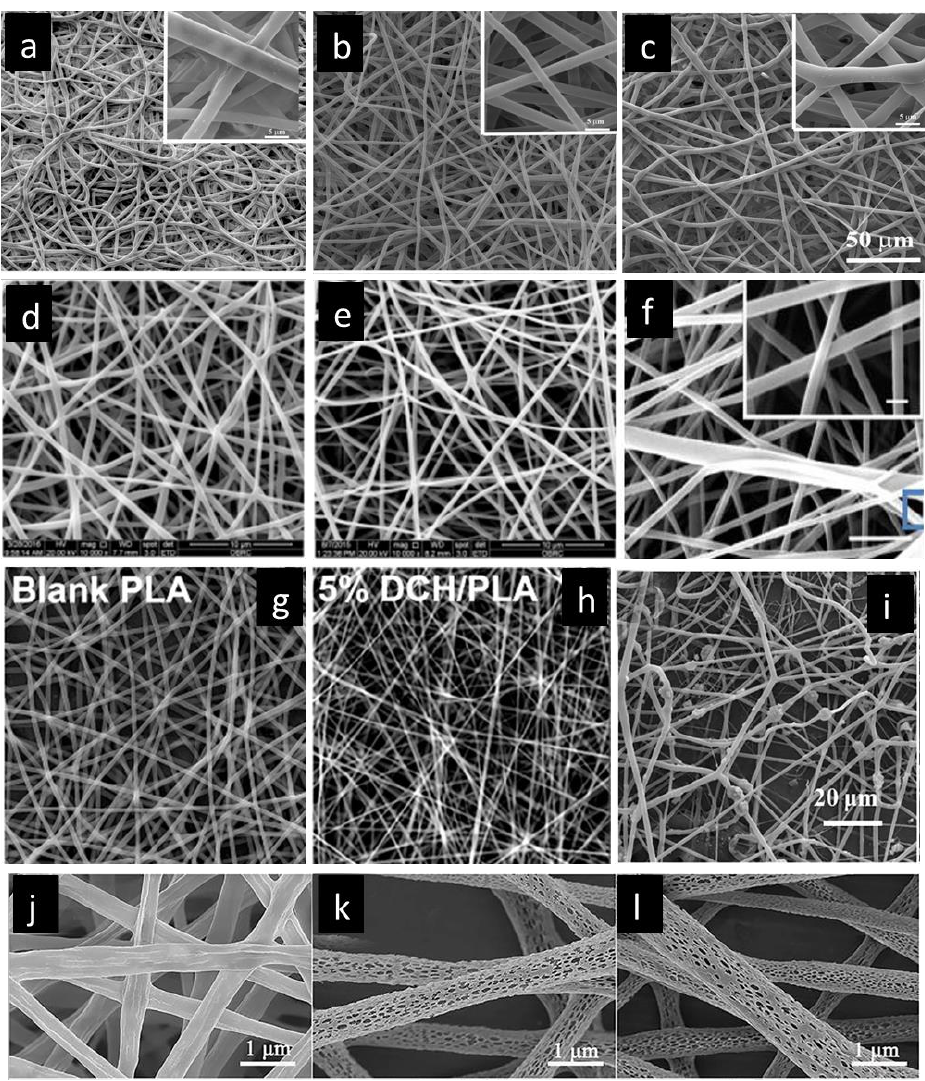
Figure 11. SEM images of the PLA e(PLA-D) fibrous mats ( a ) pure, ( b ) with 14% of BET and ( c ) DEX, reproduced with permission from [2] (License number: 5232480112869), SEM images of neat ( d ) and curcumin-loaded PLLA fiber mats ( e ) reproduced with permission from [74] (License number: 5232490308135). ( f ) SEM micrographs of electrospun PLA/CUR/PEG nanofibers containing 10 wt% of PEG with a molecular weight of 400, reproduced with permission from [70] (License number: 5232490801255), Morphology of ( g ) the pure PLA nanofibers and ( h ) PLA nanofibers with 5% DCH contents, reproduced with permission from [78] (License number: 5232491264115). ( i ) SEM images of Ag2[HBTC][im]-PLA composite fibrous mat Reproduced with permission from [79] (License number: 5232491480582). SEM images of the electrospun fibers of ( j ) neat PLLA, ( k ) PLLA/POSS and ( l ) PLLA/POSS/pAng, reproduced with permission from [87] (License number: 5272940375894).